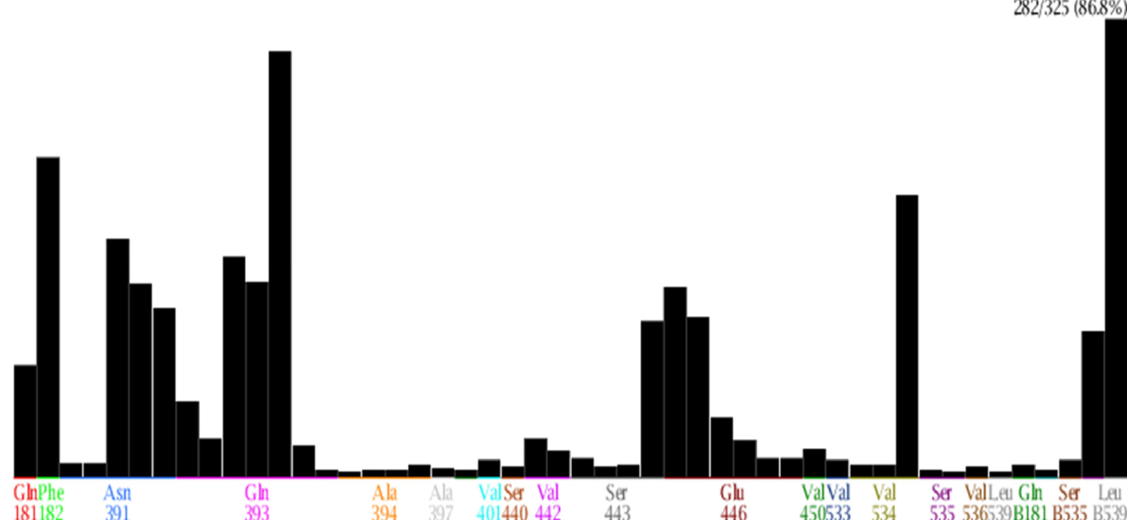
Figure 10 . The frequency of amino acids interacting in the binding site .